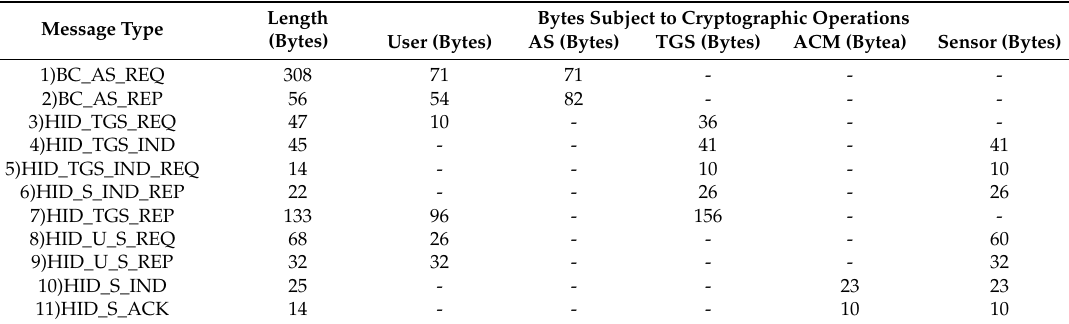
Table 5. Lengths of THE enhanced Hidra protocol messages and number of bytes over which each entity must perform cryptographic